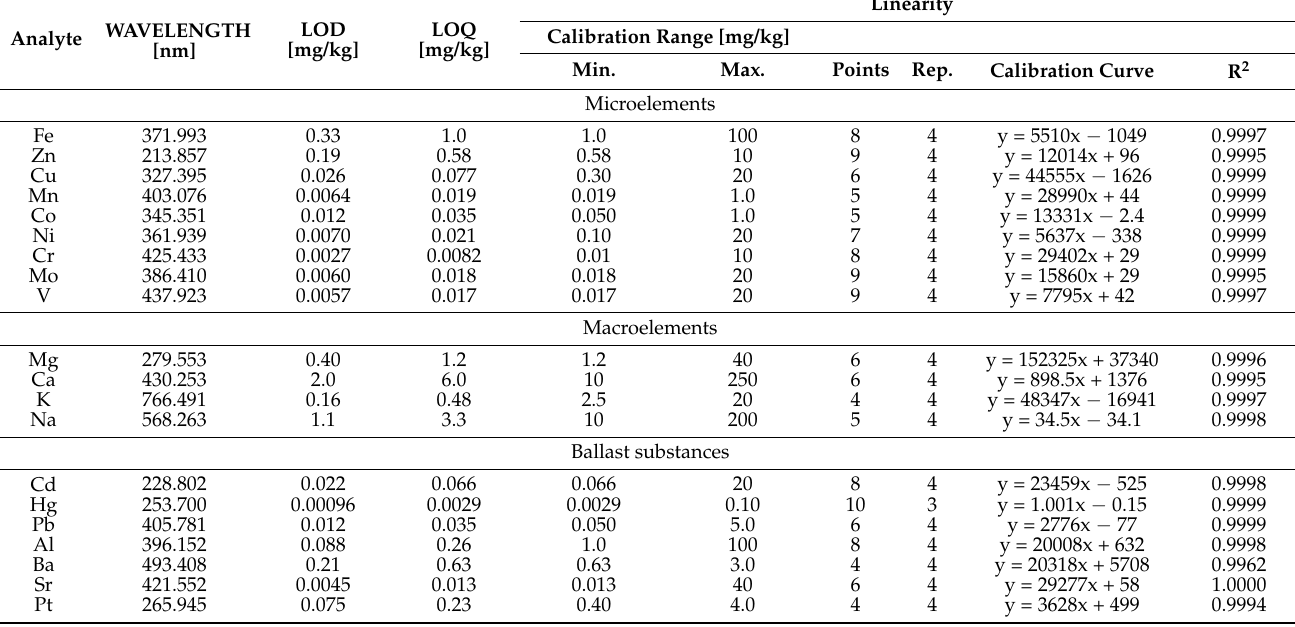
Table 7. Validation parameters of the procedure for the determination of the selected elements in lime